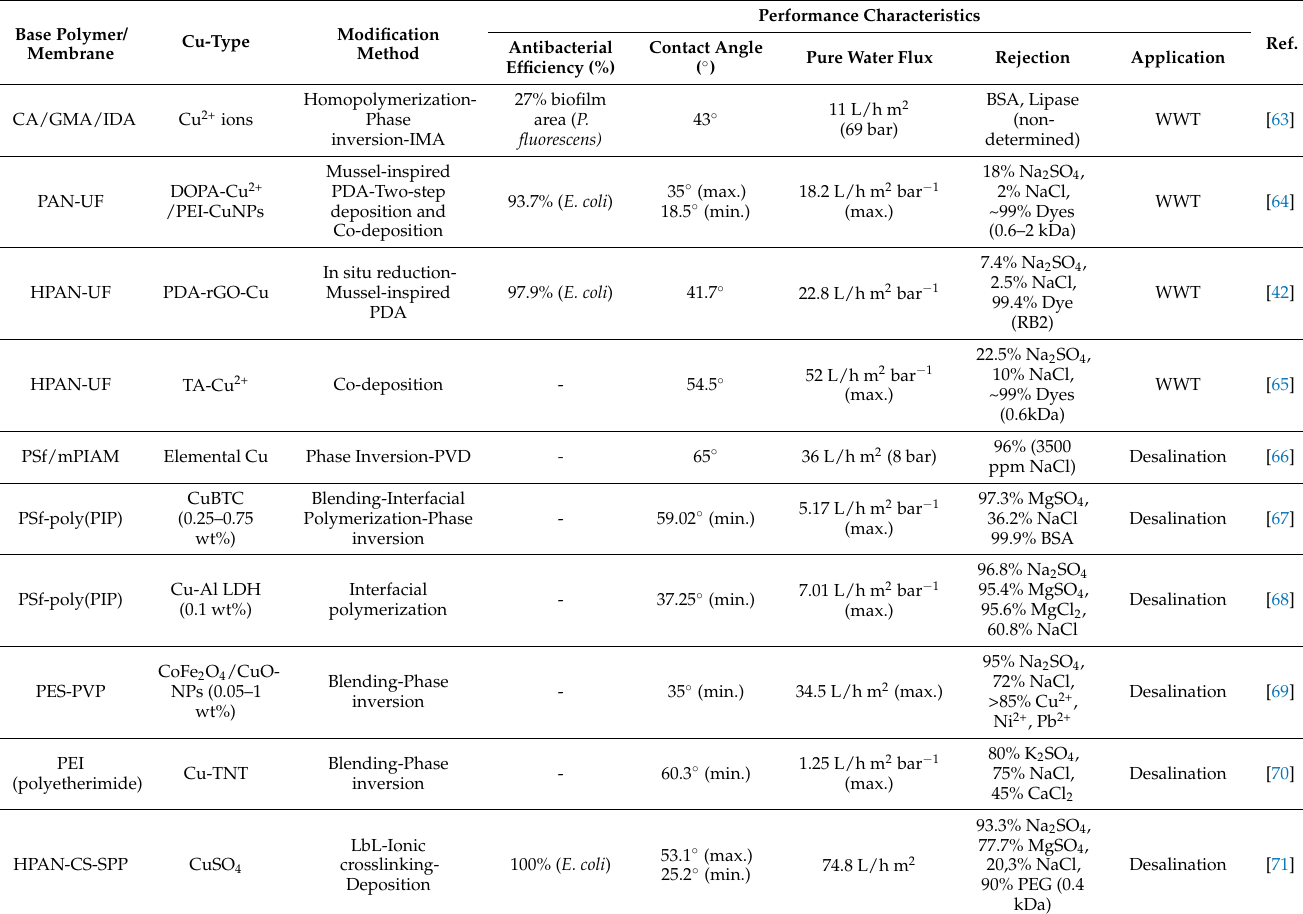
Table 4. Summary of NF membranes modified with copper-containing